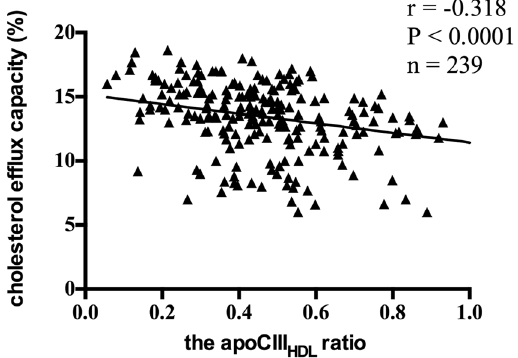
Figure 5. The correlation of the apoCIII HDL ratio and cholesterol efflux capacity in all the subjects (n = 239). ApoCIII HDL indicates apolipoprotein CIII in apoB-depleted plasma.